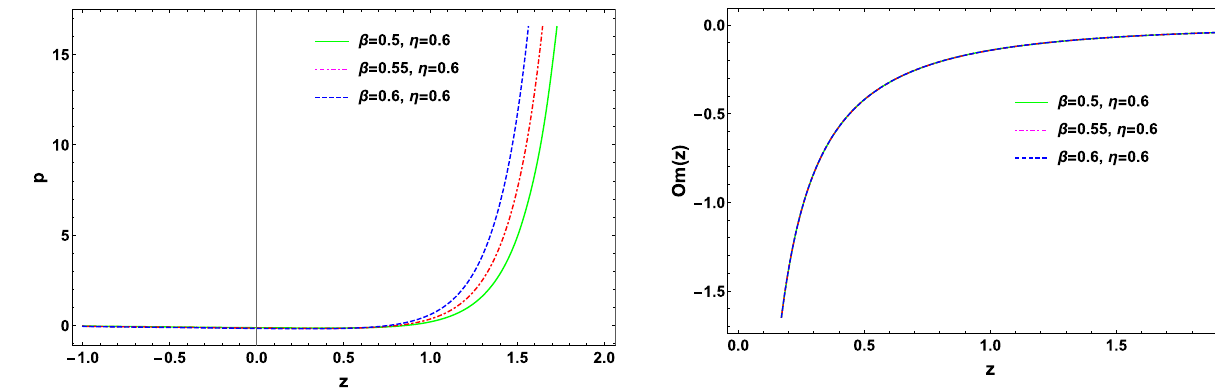
Fig. 20 Variation of Om(z) against z with H 0 = 67 . 77 km s − 1 M pc −